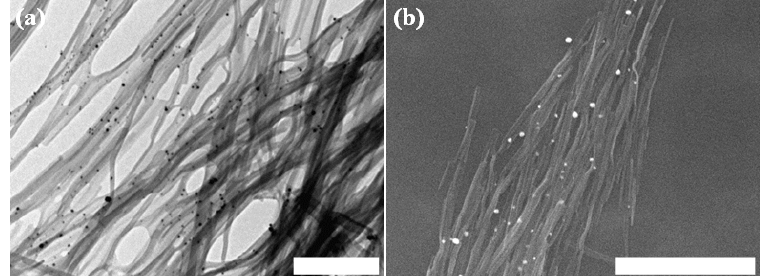
Figure 7. Silver reduction by the Asp-DOPA-Asn-Lys-DOPA fibrillar assemblies. ( a ) TEM micrograph, negative staining was not applied. Scale bar represents 500 nm; ( b ) respective SEM micrograph, metallic coating by sputtering was not applied. Scale bar represents 2